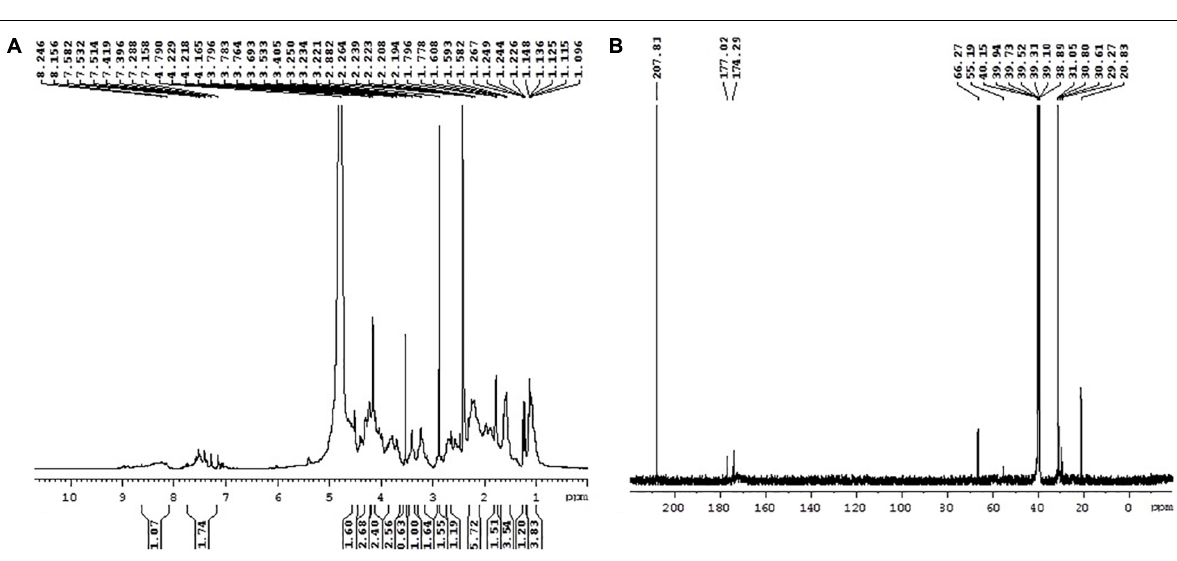
FIGURE 5 | 1 H NMR (A) and 13 C NMR (B) spectra of MSI